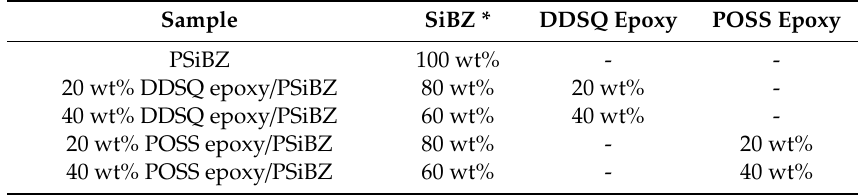
Table 1. Composition of double-decker silsesquioxane (DDSQ) epoxy/ polysiloxane-imide-containing